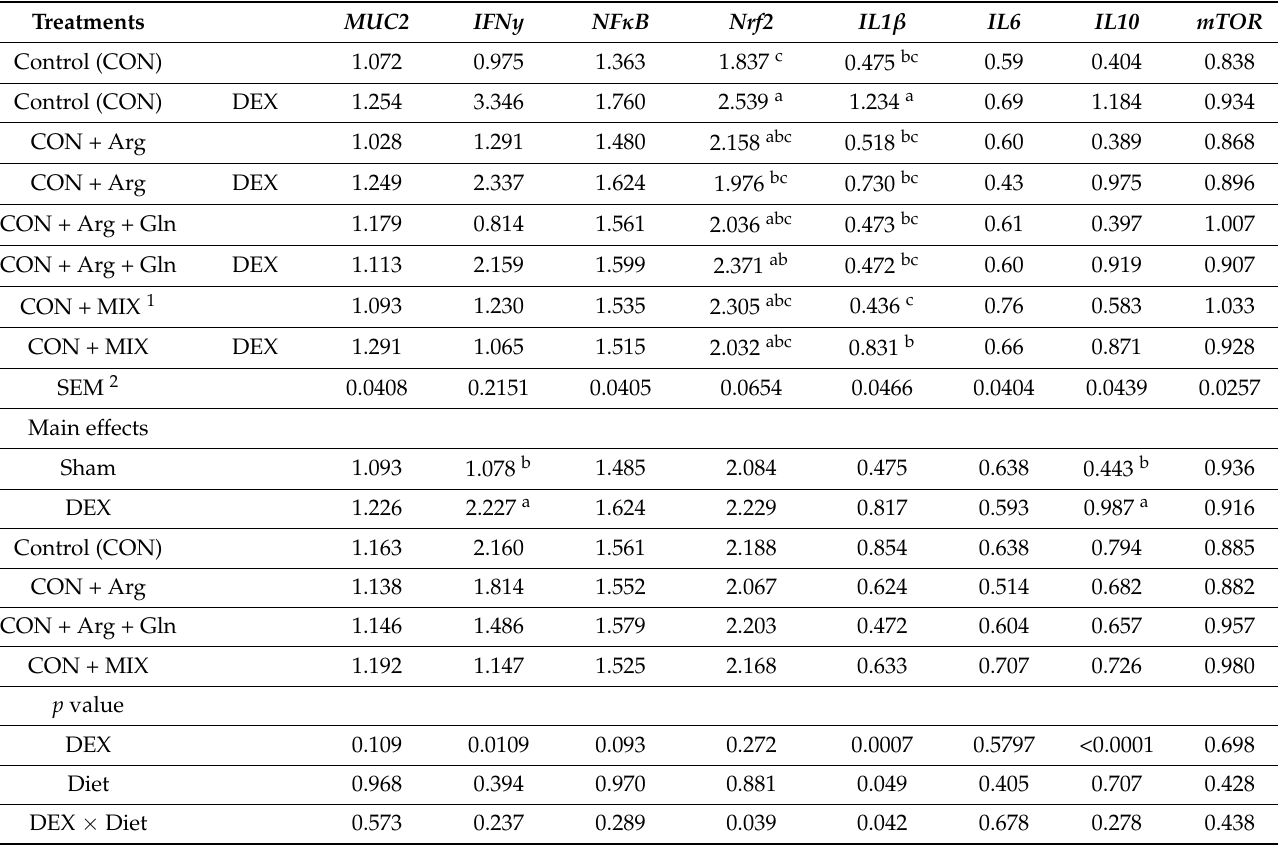
(Table 9). DEX did not change the sodium glucose cotransporter-1 (SGLT1) expression in the ileum but MIX increased ( p < 0.05) it compared with other three treatments. The level of mRNA for glutathione synthetase ( GSS ) was independently increased ( p < 0.05) in birds fed a diet completed with MIX compared with CON and Arg-Gln treatments as well as